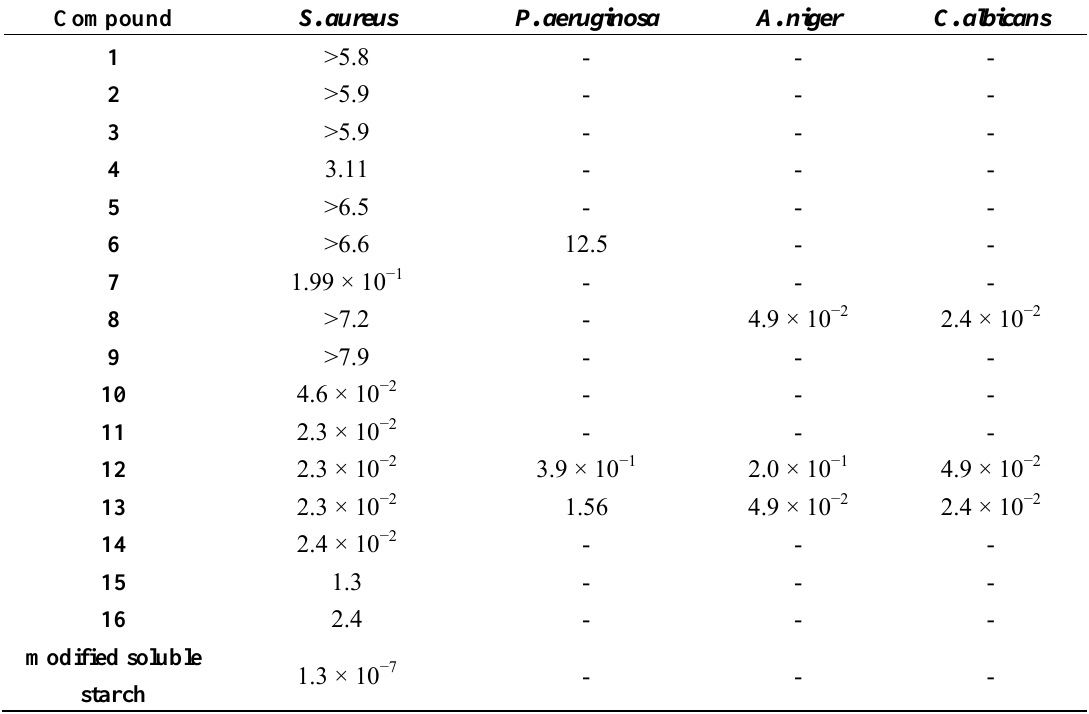
Table 3. Activity of synthesized materials toward S. aureus and other organisms (MIC; mg/mL).